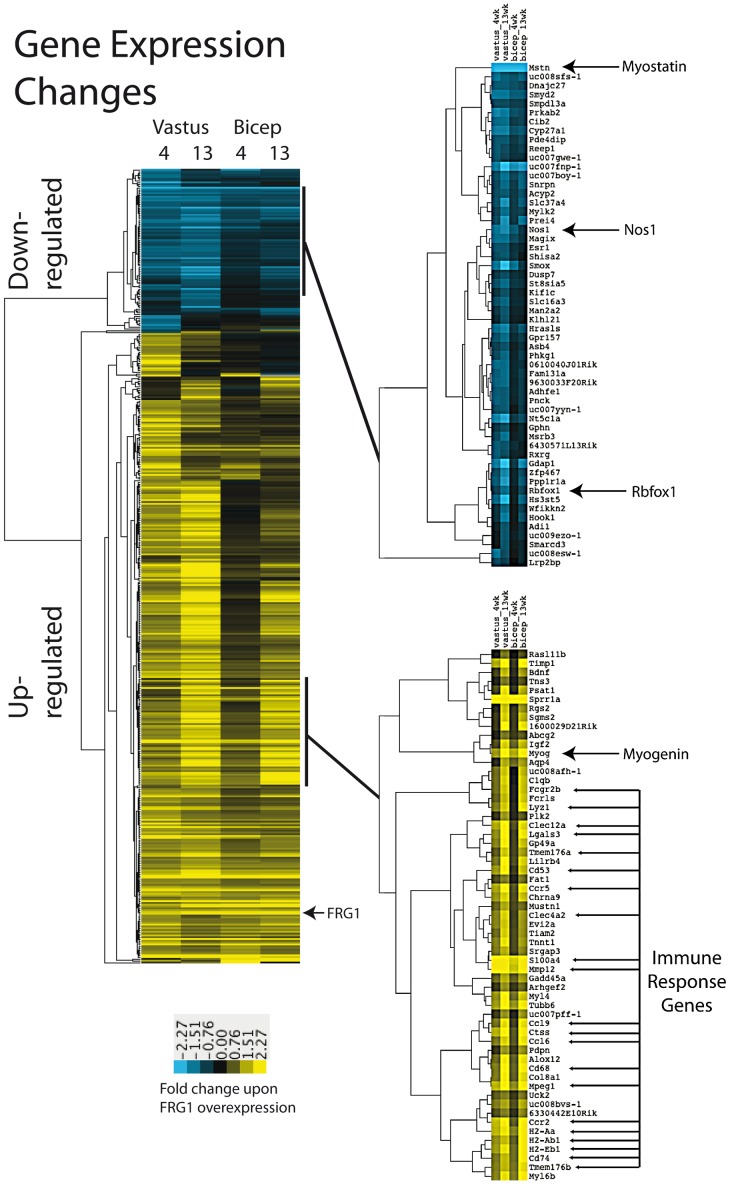
Gene expression changes in muscles of mice over-expressing FRG1.Average linkage clustering was applied to the fold change values of the 440 genes whose expression changes by at least 2 fold (SAM q<0.5) in at least one of the four comparison datasets. Selected nodes are expanded on the right. Genes with increased expression in FRG1 over-expressing muscles are shown in yellow in the heatmap, while those whose expression decreased are in blue.